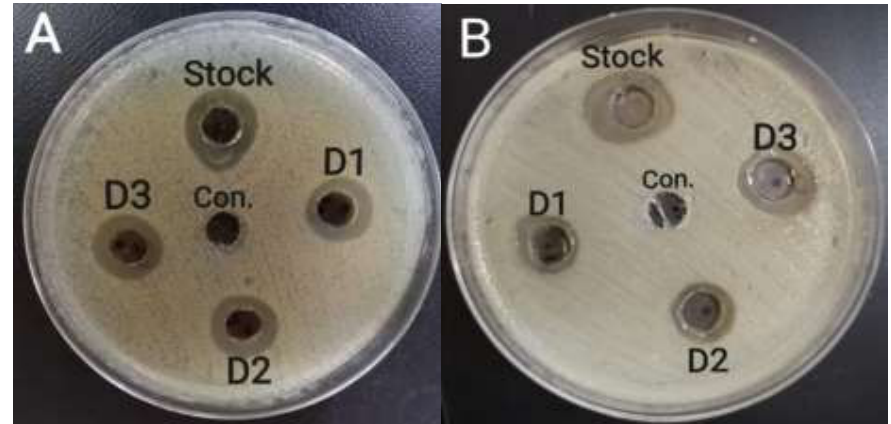
Figure 6: The inhibitory effect of Silver nitrate against bacterial isolates. (A) S.haemolyticus , (B) K.pneumoniae , D1= 12.5%, D2= 25%, D3= 50%, stock=100% concentrations, cont.=control